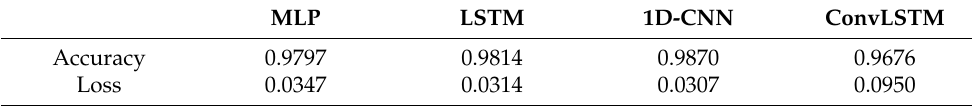
Table 2. Performance comparison of the four machine learning